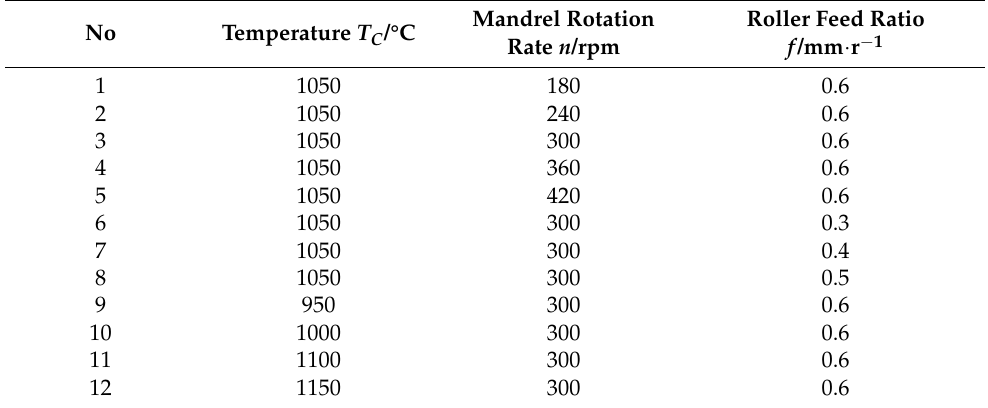
Table 4. Single factor experimental